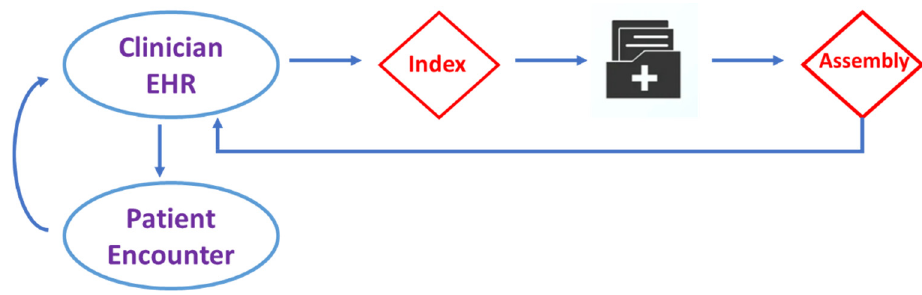
Figure 1. A scheme of the HII, typically used in Italian regions. As the records are not centrally stored, at least one central index is needed, from which the information for a particular patient can be extracted. When the patient data are requested, the index is used to query the repository where the stored information is located. The answers to these questions are then assembled (in real time) to produce the the physician’s EHR